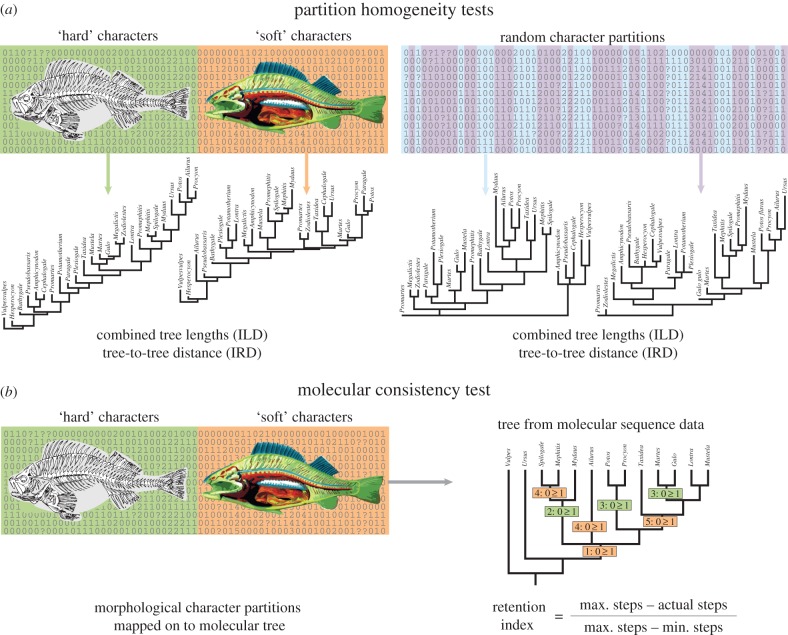
Tests applied to morphological character partitions. Partition homogeneity tested (a) by the Incongruence Length Difference (ILD) test and Incongruence Relationship Difference (IRD) test; the trees resulting from searches using each partition are compared with trees resulting from searches using random partitions of the same size in terms of tree length summed for the two partitions or average nearest neighbour tree-to-tree distance between most parsimonious trees of the two partitions. Molecular consistency tested (b) by optimizing morphological data onto molecular trees and comparing the resulting retention indices of characters and partitions. (Online version in colour.)